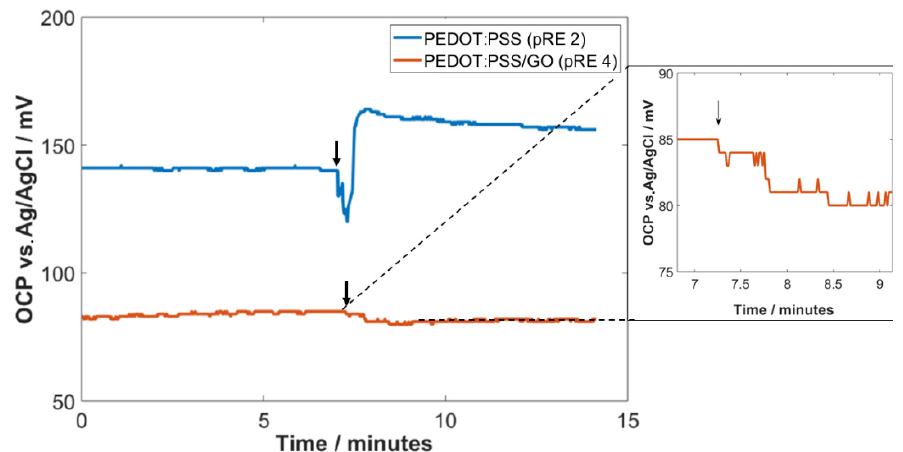
Figure 4. Impact of the addition of higher ionic strength droplets on the OCP of pRE 2 and pRE 4. The black arrows indicate the addition of high ionic strength solution.